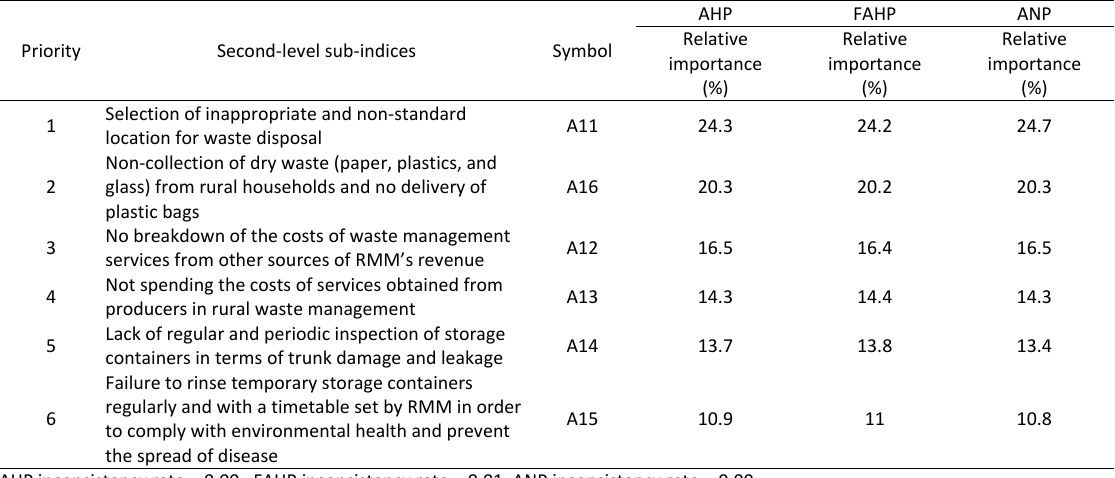
Table 1: Prioritization of weaknesses and relative importance values of the sub-indices of the A1 index based on AHP, FAHP, and ANP